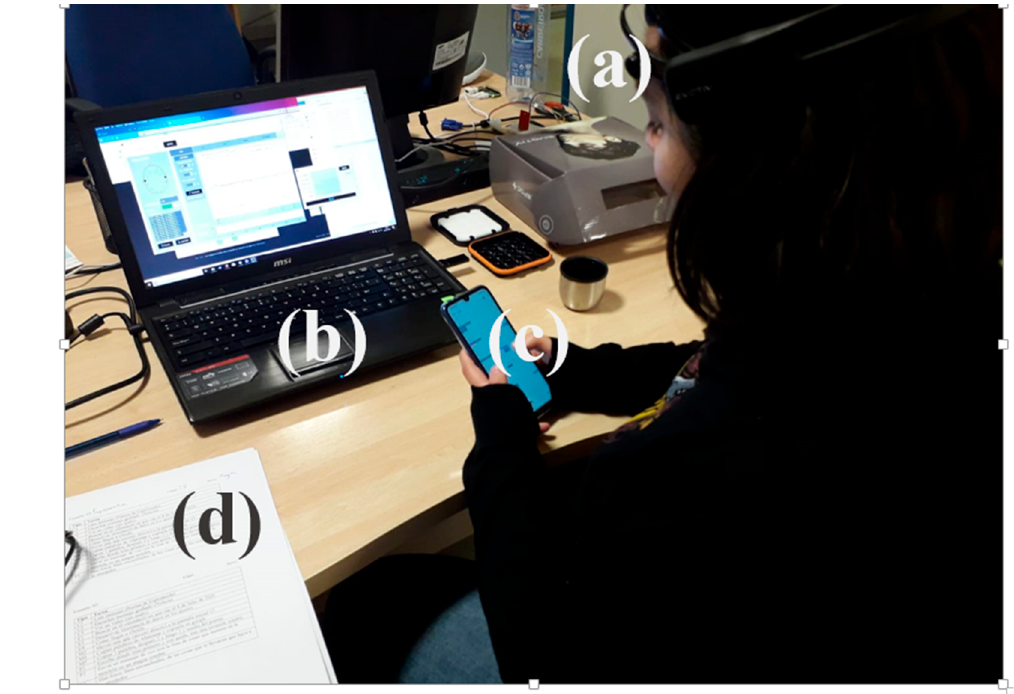
Figure 1. Experiment setup with the following materials: ( a ) Emotiv Epoc + EEG headset; ( b ) Laptop with the required software: Xavier TechBench Software TM to collect raw data and eeglib to process and analyze; ( c ) Mobile phone Samsung J6 with Android 9.0 Pie; ( d ) task sheet with the experiment instructions and the consent